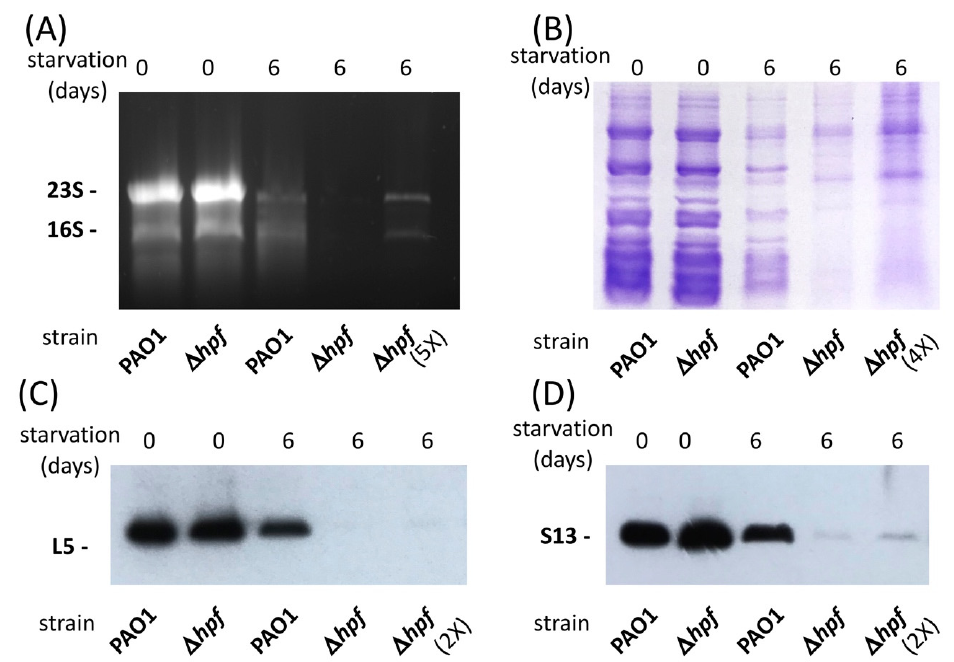
Figure 1. Analysis of P. aeruginosa ribosomes, partially purified using sucrose cushions. Ribosomes were purified from pre-starved cells and from 6 d starved cultures. ( A ) rRNA extracts of purified ribosomes from P. aeruginosa and from the ∆ hpf strain prior to starvation and after 6 d of starvation. ( B ) SDS-PAGE of purified ribosomes of pre-starved and 6 d starved cultures. ( C ) Immunoblot analysis of protein L5 from pre-starved cultures and 6 d starved cultures. ( D ) Immunoblot analysis of protein S13 from pre-starved cultures and from 6 d starved cultures. Shown are representative images from three independent replicate gels.